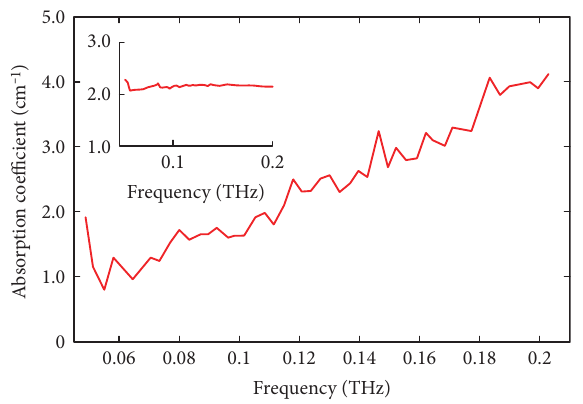
Figure 3: Propagation properties of the analogue tiles. The absorption coe ffi cient is plotted as a function of frequency, shown in units of inverse centimeters. Inset: index of refraction, plotted as a function of frequency. These measurements were computed using the method presented in [12, 13].